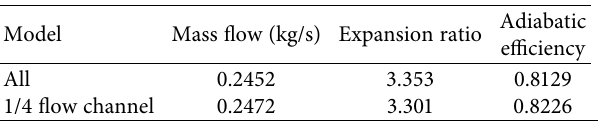
Table 3: Simulation results of the whole machine and 1/4 flow channel.